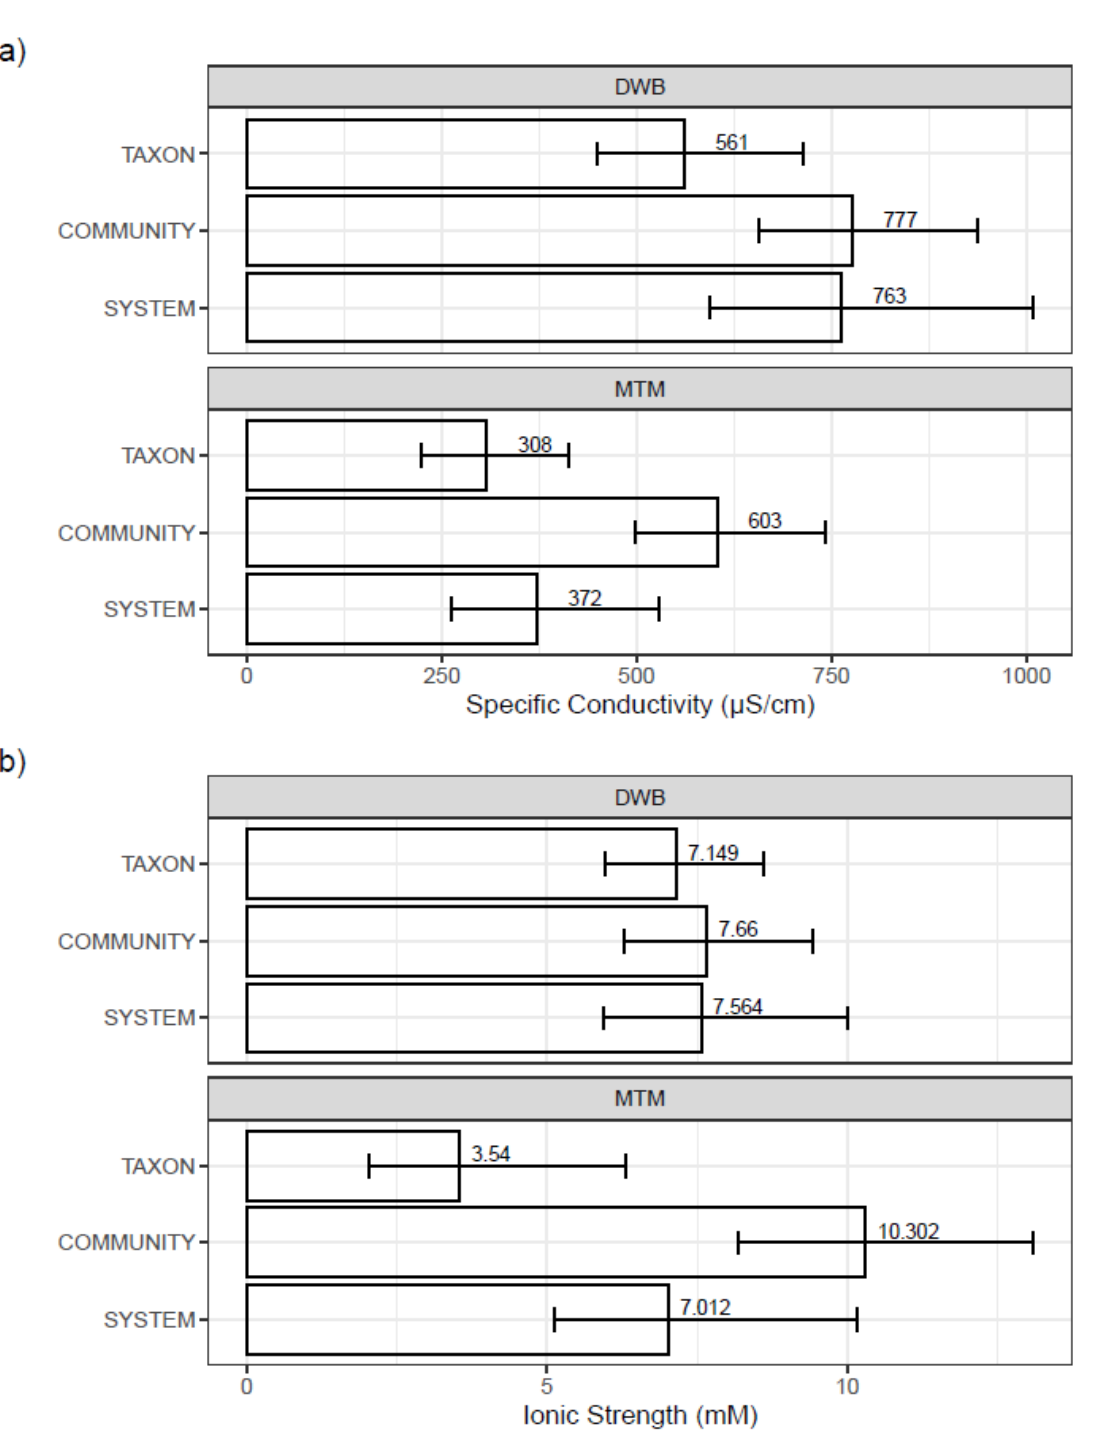
Figure 6. HC 5s by dosing recipe and level of ecological organization from RSDs based on specific conductivity ( a ) and ionic strength ( b ). Error bars are 95% confidence interval for the estimate from the RSD fitting function.